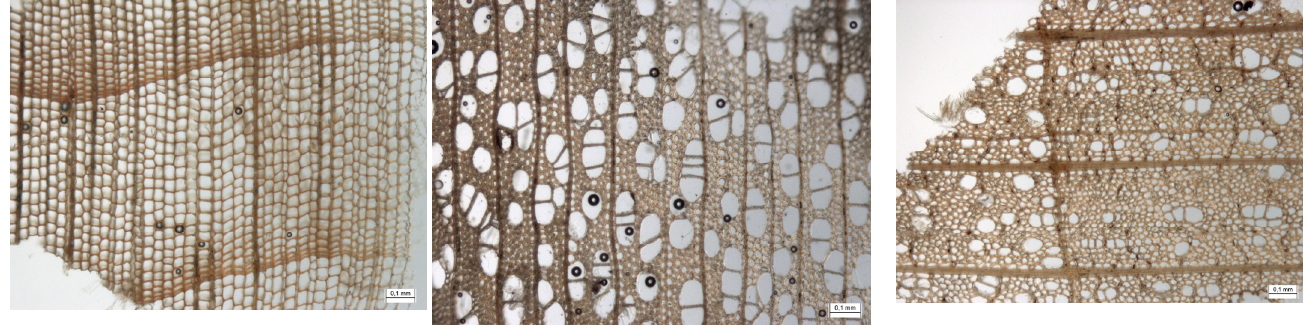
Figure 8. Cross-sections of stone pine ( left ), poplar ( centre ), and lime tree ( right ).